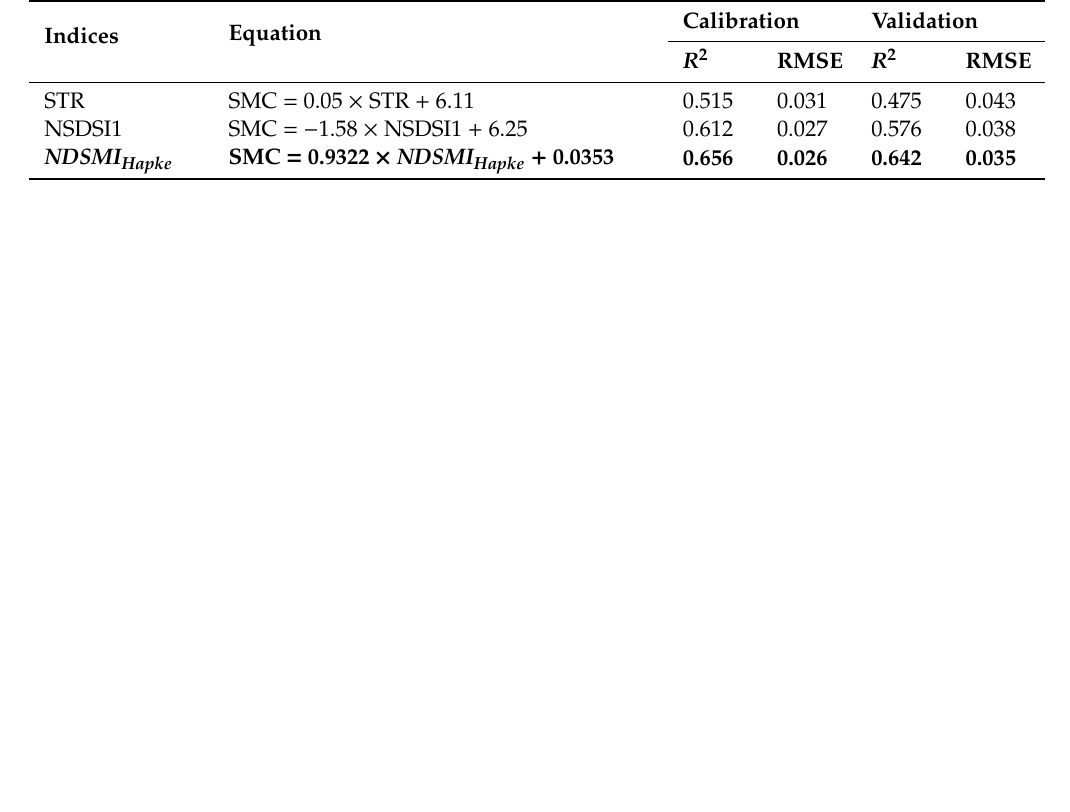
Figure 18. The SMC estimated and measured by using: ( a ) STR, calibration sites; ( b ) STR, validation sites; ( c ) NSDSI1, calibration sites; ( d ) NSDSI1, validation sites.